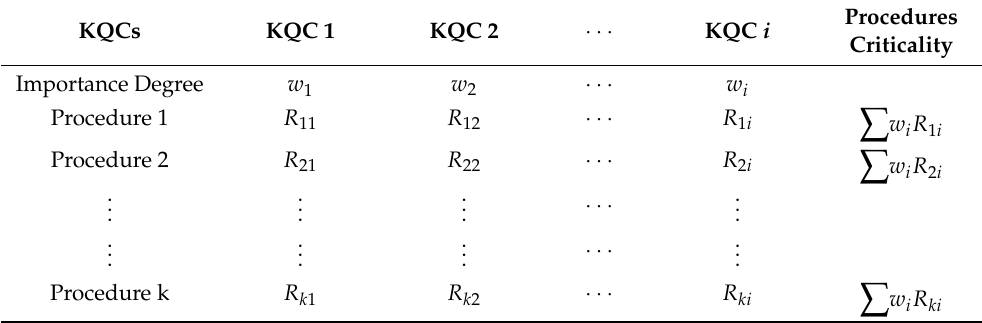
Table 1. Calculation matrix of procedures